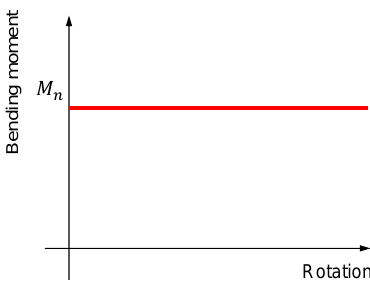
Figure 21. Bending moment-rotation relation of the beam and column members for push-over analysis.